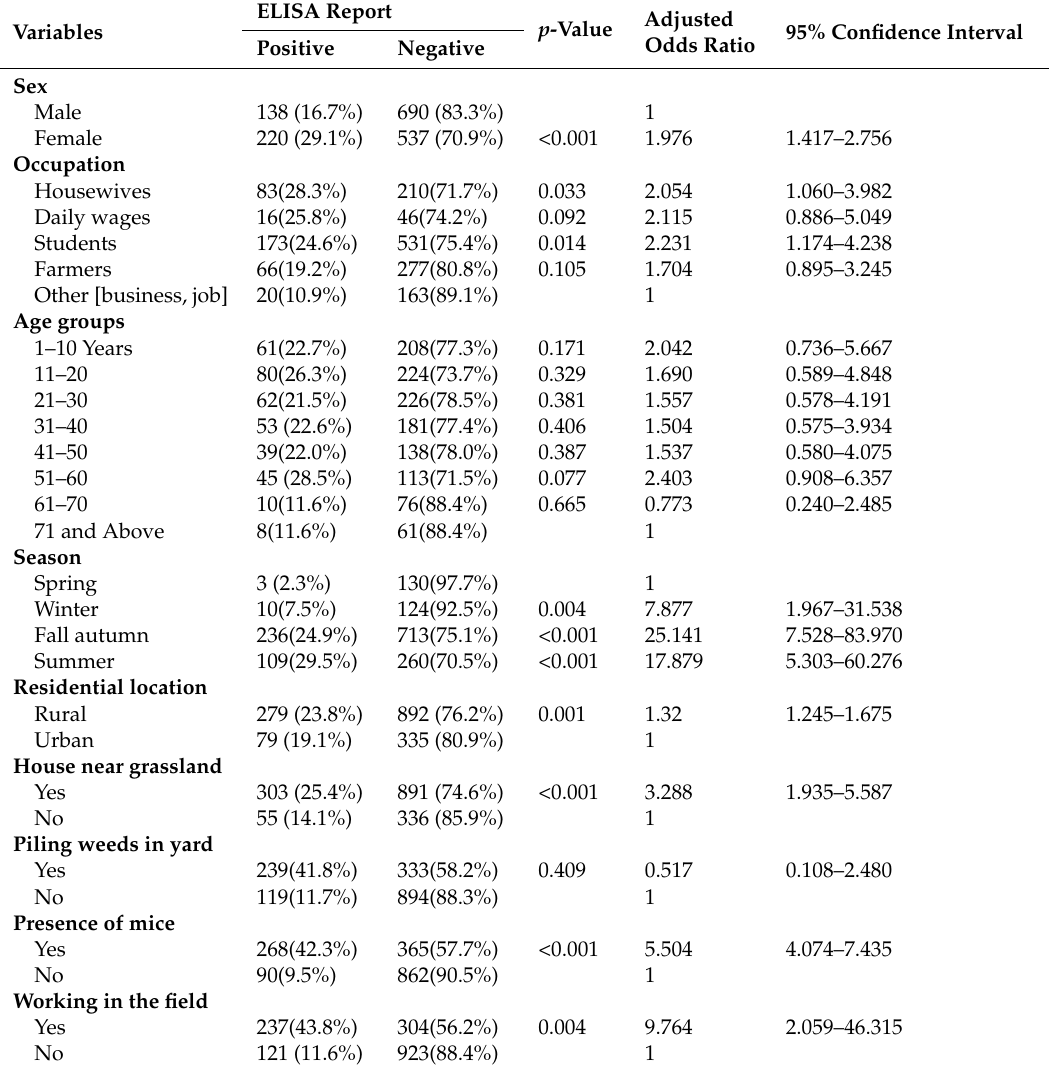
Table 5. Multivariate analysis of association of ELISA report with socio demographic